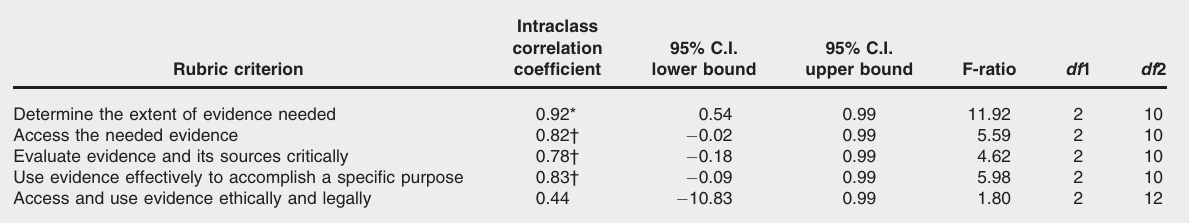
Inter-rater reliability for scoring of the peer review essay in the second